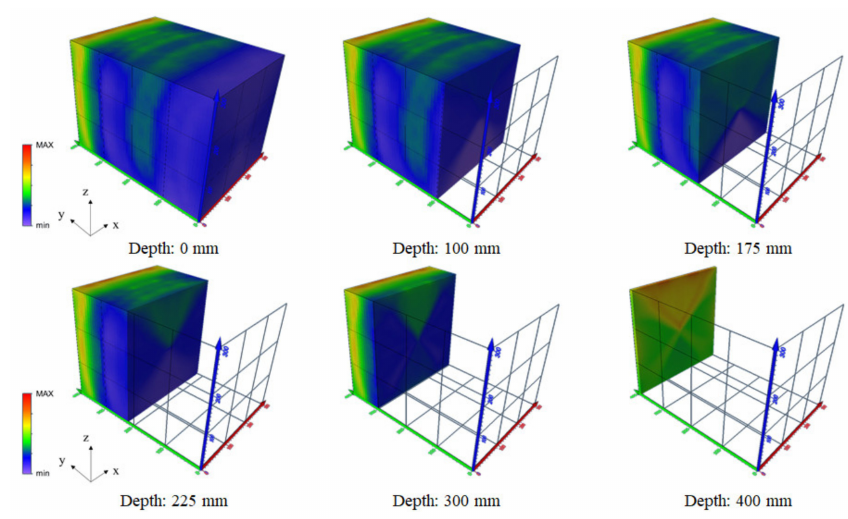
Figure 15. Result of 3D SIBIE procedure for intact concrete specimen.